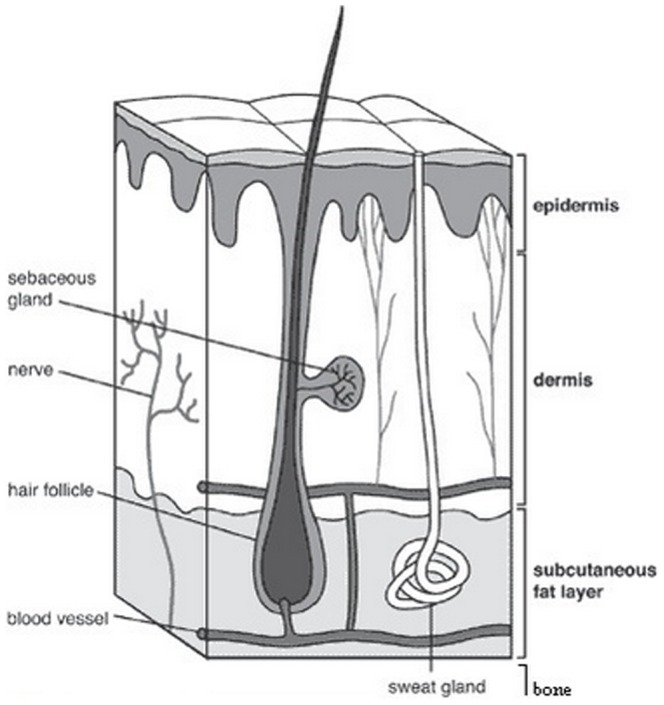
Soft tissue anatomy of finger.(a) Layers of finger model. (b) 3D mesh from ANSYS.